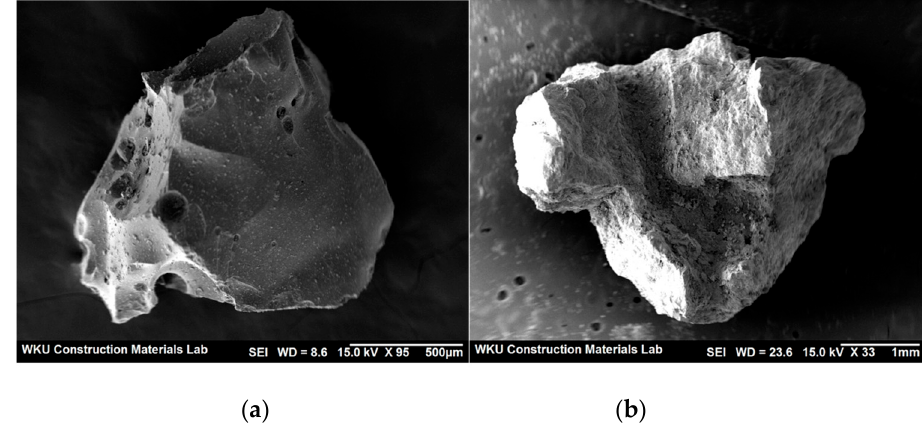
Figure 1. SEM images of steel slag fine aggregates: ( a ) BS and ( b ) FS.